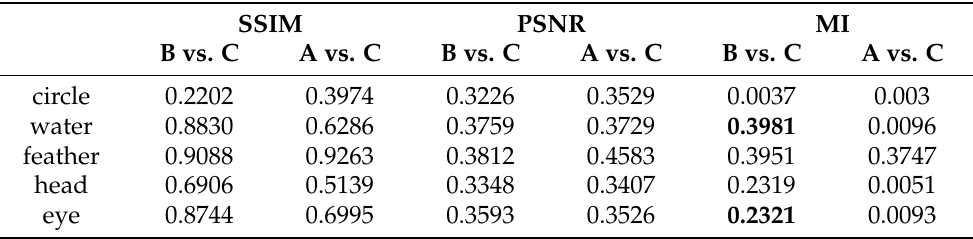
Table 1. Comparison of image quality and similarity metrics between incomplete signs A, predicted signs B, and ground truth signs C. Their range is from 0 to 1, where 1 means images are more alike. For this evaluation, only the best decoration completion results are considered. These are highlighted with a red rectangle in Figure